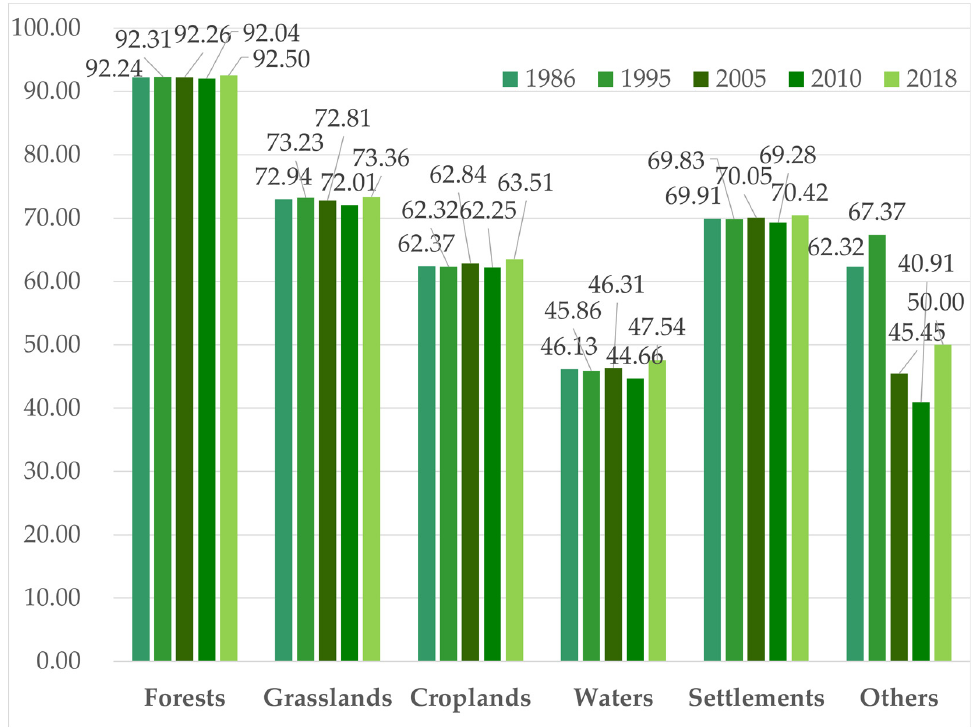
Figure 8. Changes in the AI from 1986 to 2018.